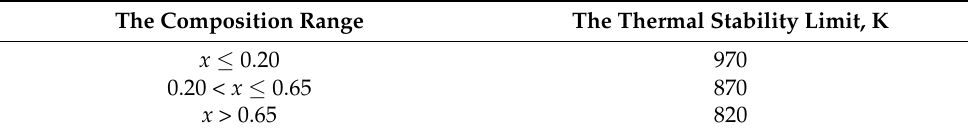
Table 1. The thermal stability limit of the high-pressure synthesized perovskite phases in the (1- x )BMT– x BZT system. The Composition Range The Thermal Stability Limit, K x ≤ 0.20 970 0.20 < x ≤ 0.65